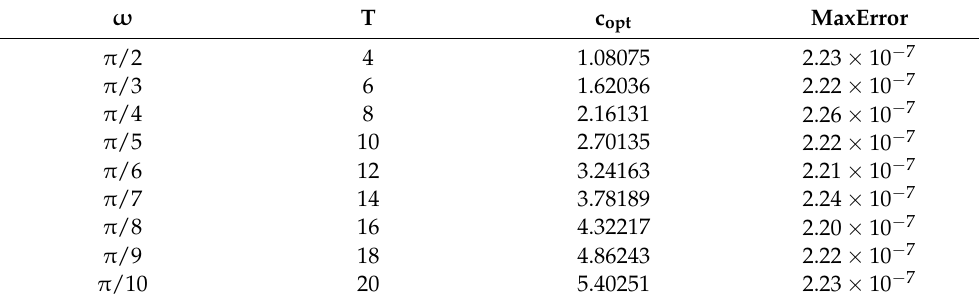
Table 6. Partial results of ω = π /k ( k = 2, . . . ,10 ) .